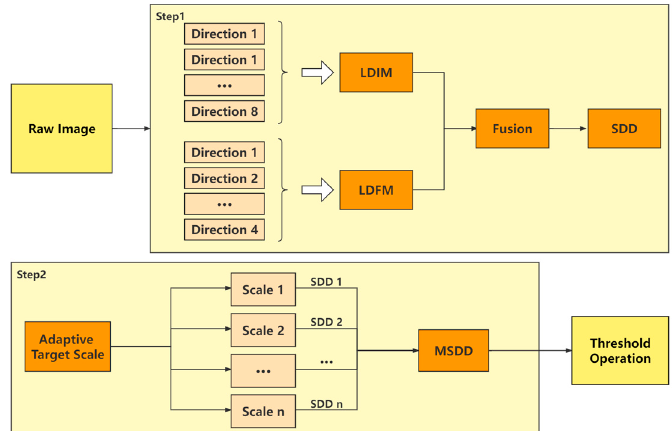
Figure 2. Flowchart of our MSDD small target detection method.